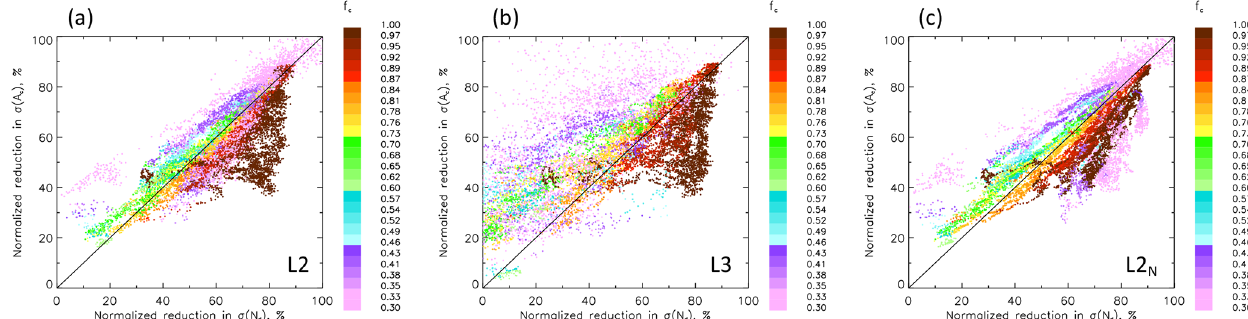
Figure 7. Effects of aggregation on normalized reduction in σ ( A c ) vs. normalized reduction in σ ( N d ) to shed light on results in Fig. 5. Points are colored by f c . (a–c) At high (low) f c averaging tends to more significantly reduce (increase) σ ( N d ) relative to σ ( A c ). Notable exceptions occur in (c) for some low- f c conditions. See text for further discussion.